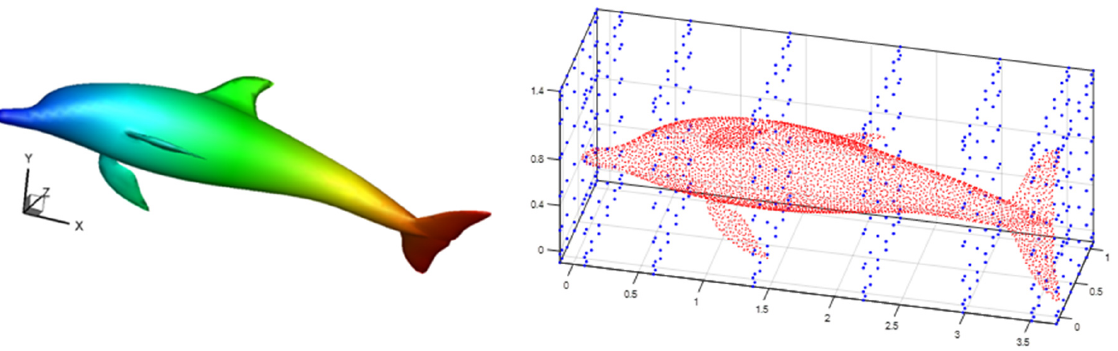
Figure 8. Geometry of the problem and the distribution of the shifted Gauss–Lobatto nodes.